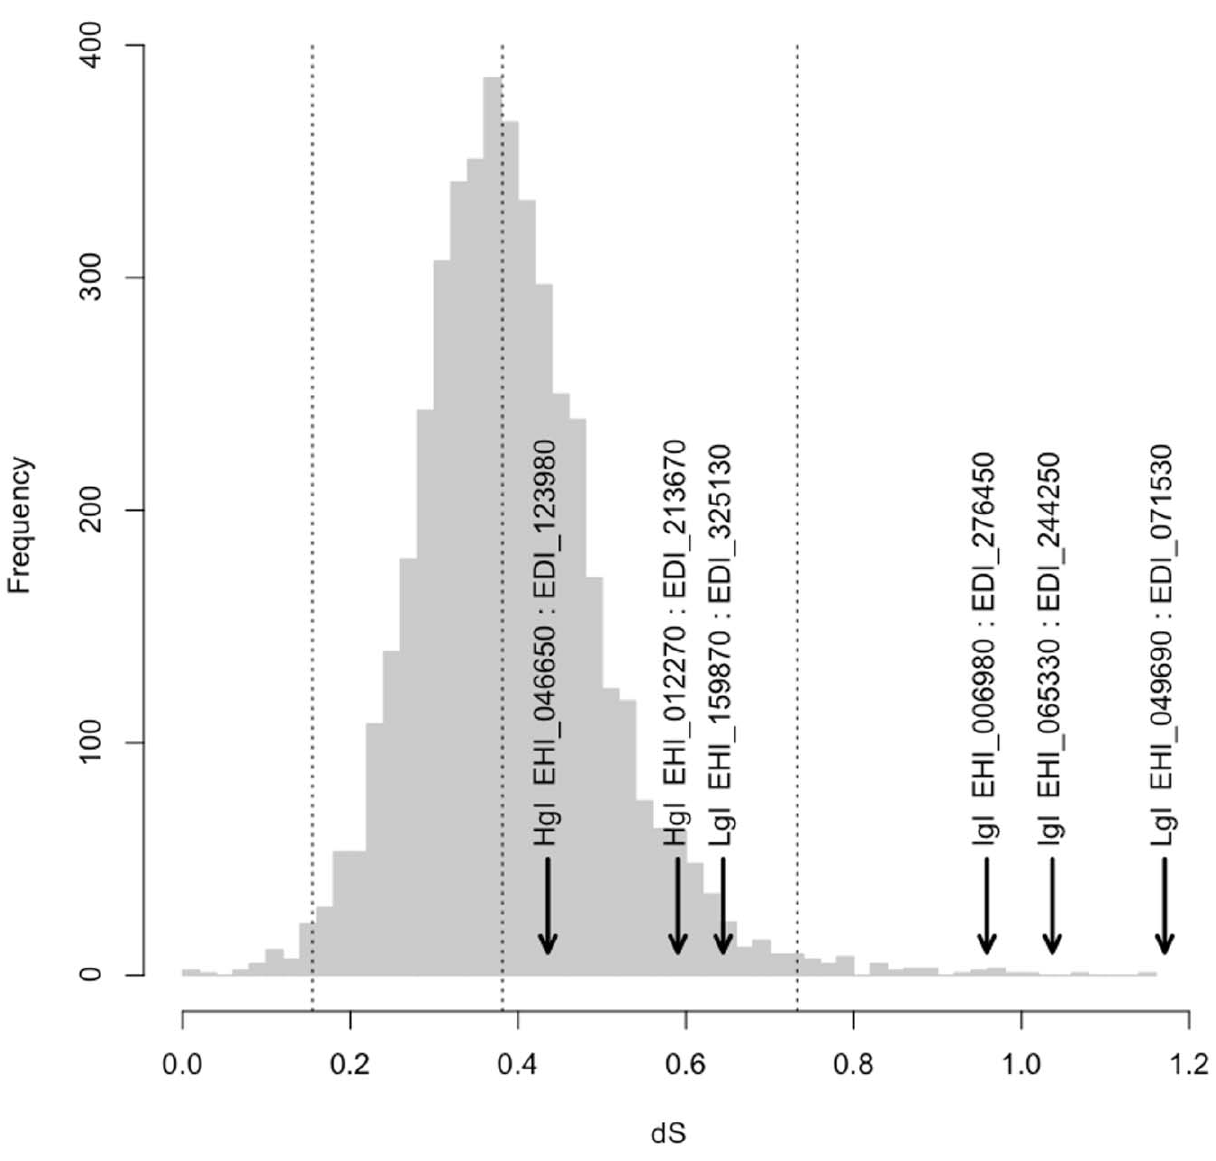
Figure 3. Divergence at synonymous sites (dS) is unusually high between igl and lgl positional orthologues. The frequency distribution of pairwise dS between 4531 putative orthologue pairs is plotted (grey bars). Dashed lines indicate 1st, 50th and 99th centile values. Pairwise dS values between hgl , igl and lgl positional orthologues are indicated. Both igl pairs and one lgl pair fall within the top 1% of dS values.